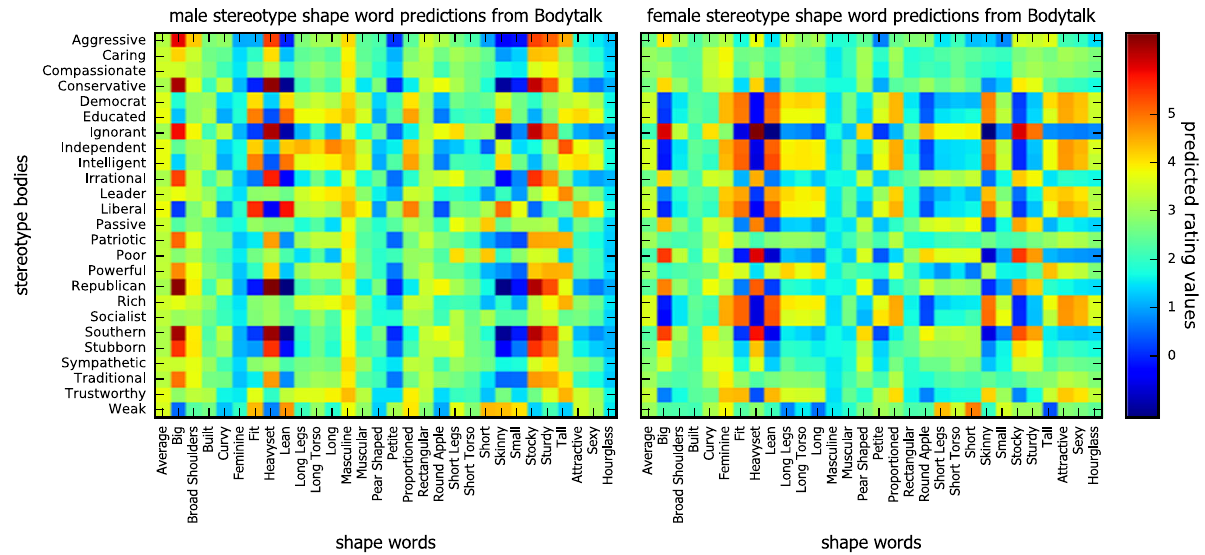
Fig. 3 Semantic relationship between political and phyisical traits. Predictions of body shape descriptions for each stereotype body using the Body Talk model (Streuber et al., 2016).